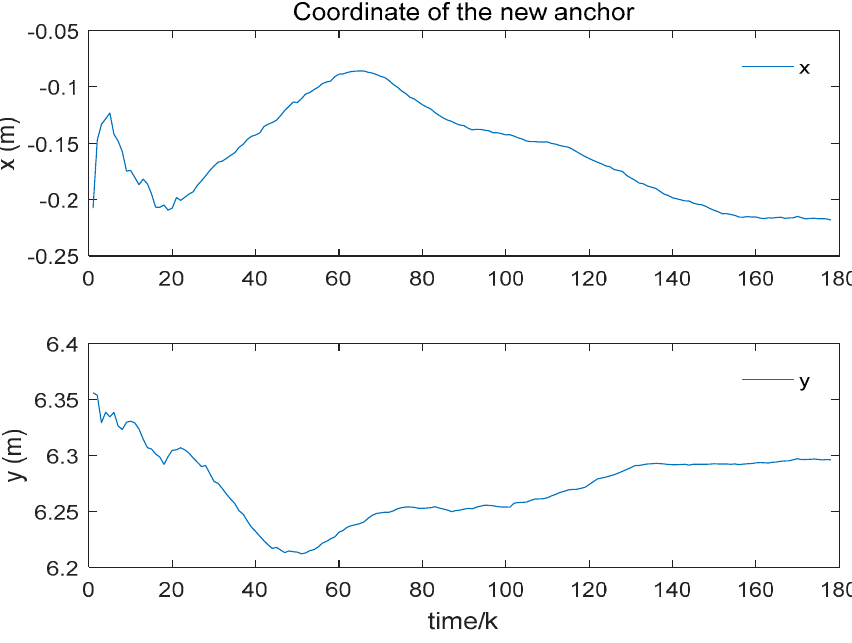
Figure 9. Coordinate estimation of the new anchor.